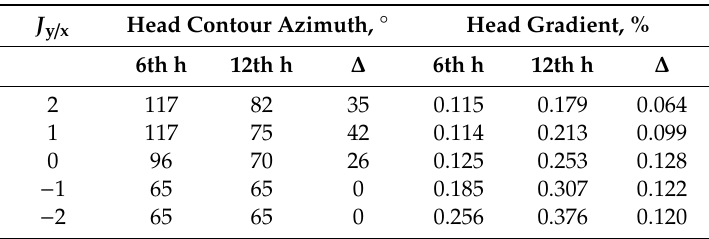
Table 3. Contour line orientations and average head gradients for all regional groundwater flux ( J y / x ) scenarios at ET80. All delta values are 12th h conditions − 6th h conditions. J y / x Head Contour Azimuth, ◦ Head Gradient,